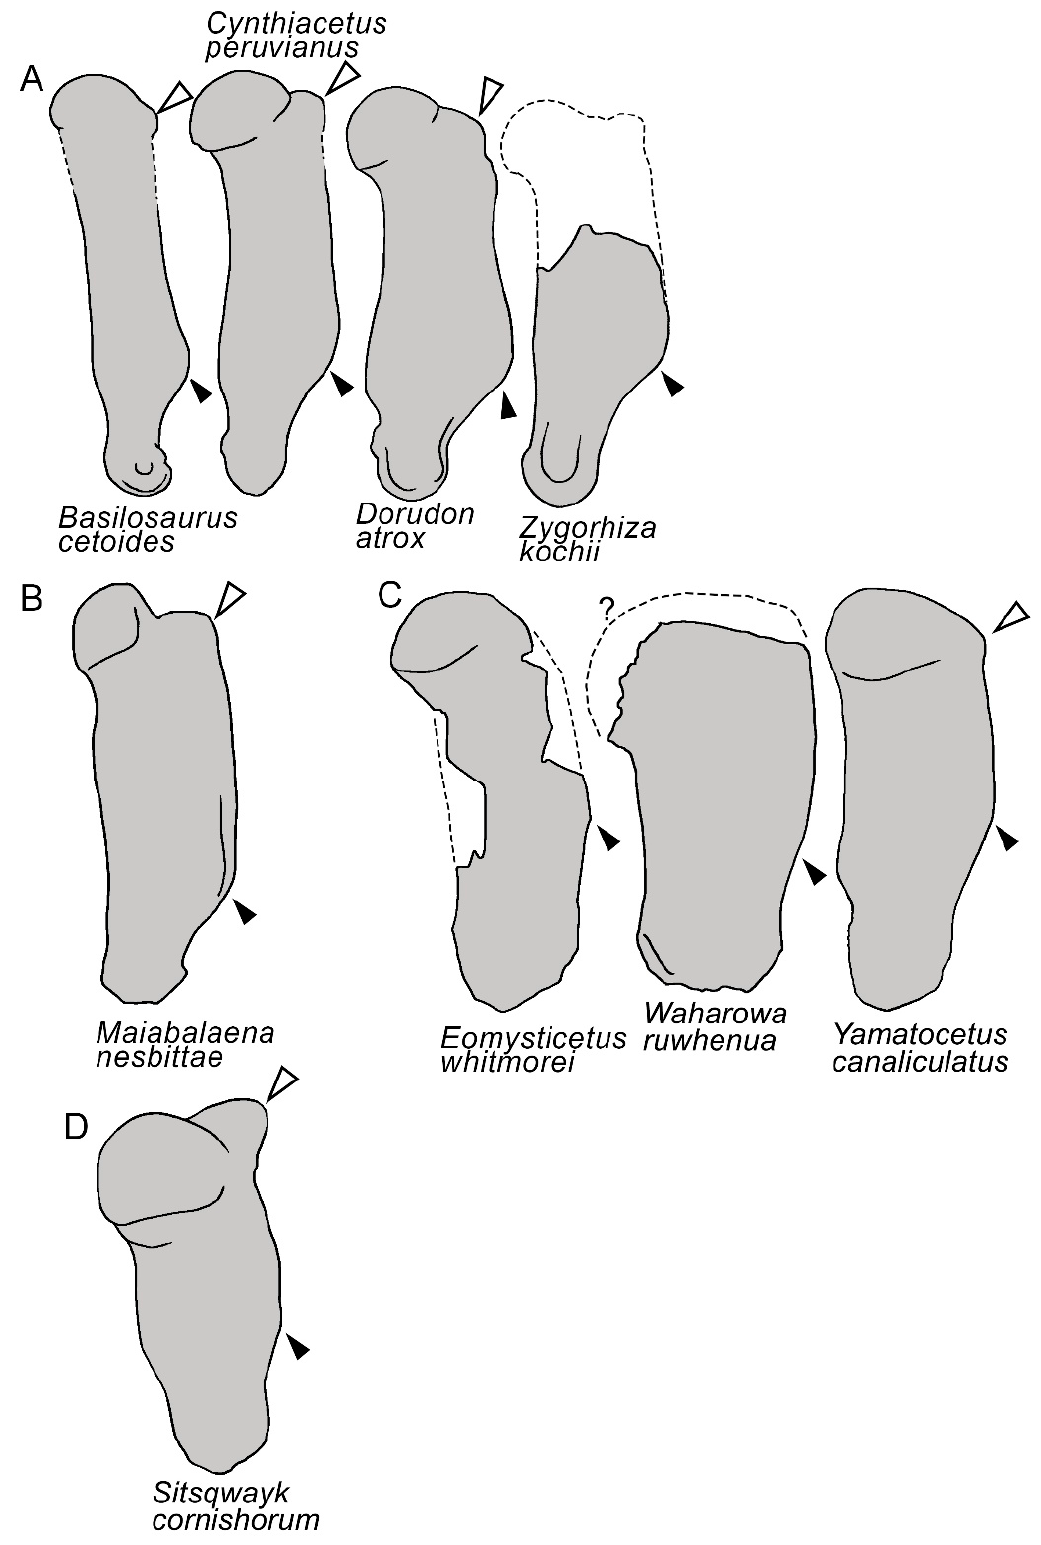
Figure 22. Humerus of archaeocetes and nonbalaenomorph mysticetes. ( A ) Archaeocetes. ( B ) Maiabalaena nesbittae . ( C ) Eomysticetidae. ( D ) Sitsqwayk cornishorum . The white triangle indicates the greater tubercles of the humerus. The black triangle indicates the maximum extension of the deltopectoral crest. Not to scale. The scapulae are represented as if they shared the same anteroposterior length.